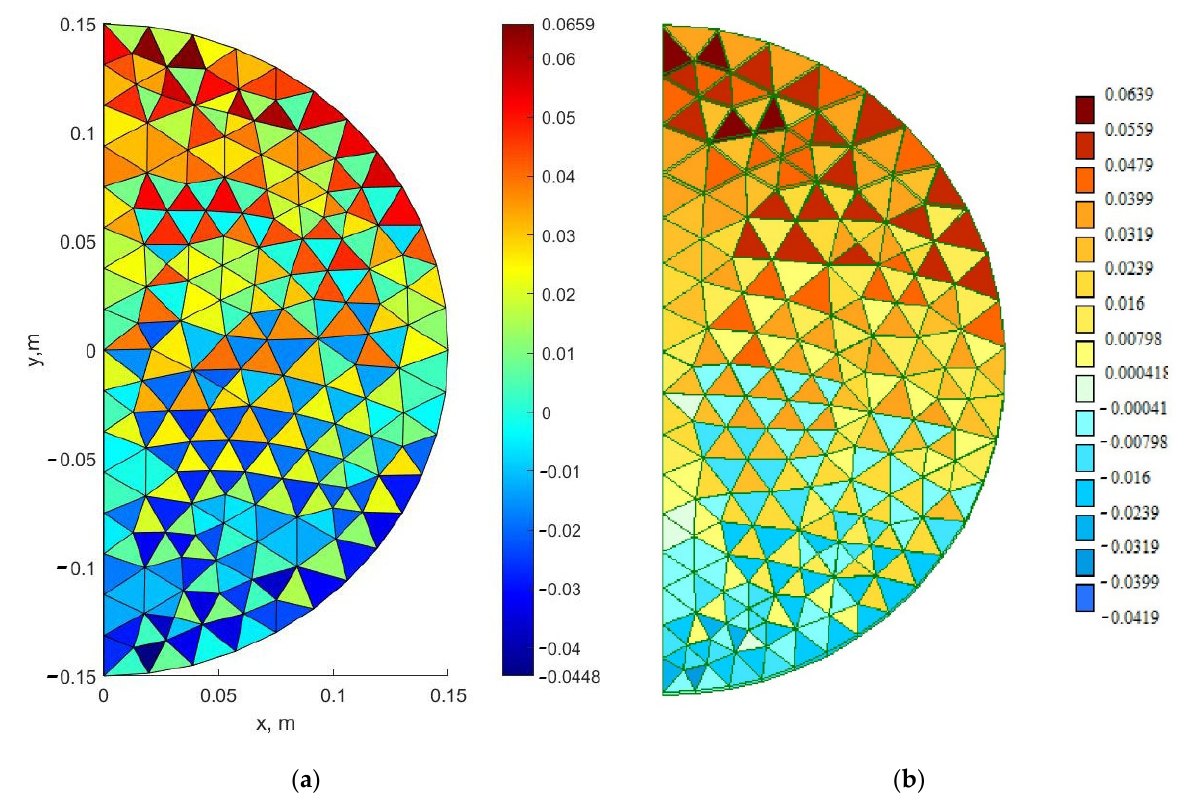
Figure 7. Mosaic of stresses σ y (MPa): ( a ) MATLAB; ( b ) LIRA-SAPR.